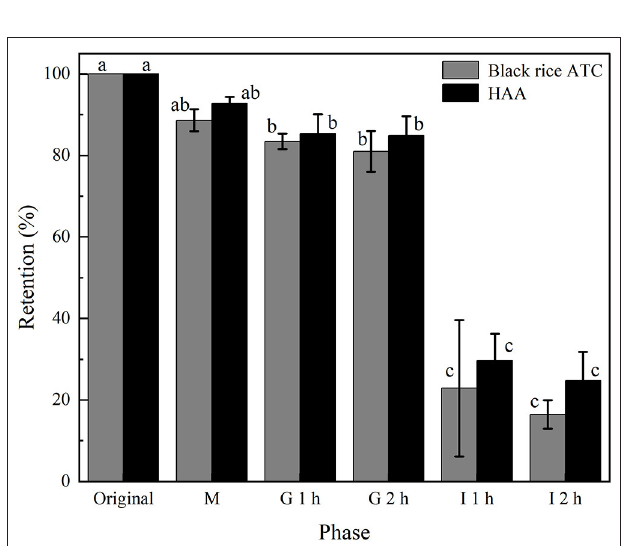
FIGURE 8 | ATC content changes of free black rice ATC and HAA nanocomposite particles during simulated digestion in vitro .